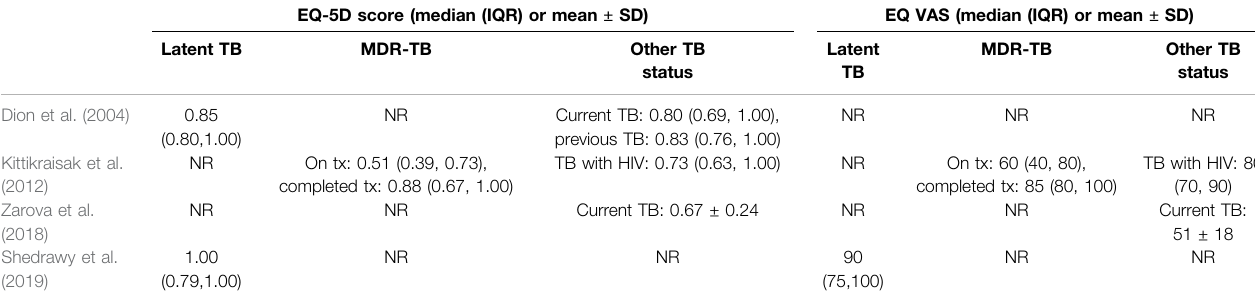
TABLE 4 | Health-related quality of life for tuberculosis patients in various disease